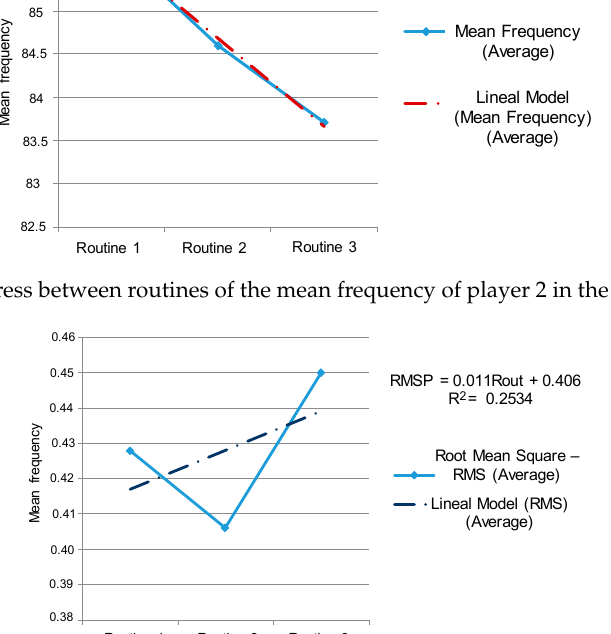
Figure 11. Progress between routines of the maximum Root Mean Square (RMS) amplitude of player 2 in the rectus femoris.